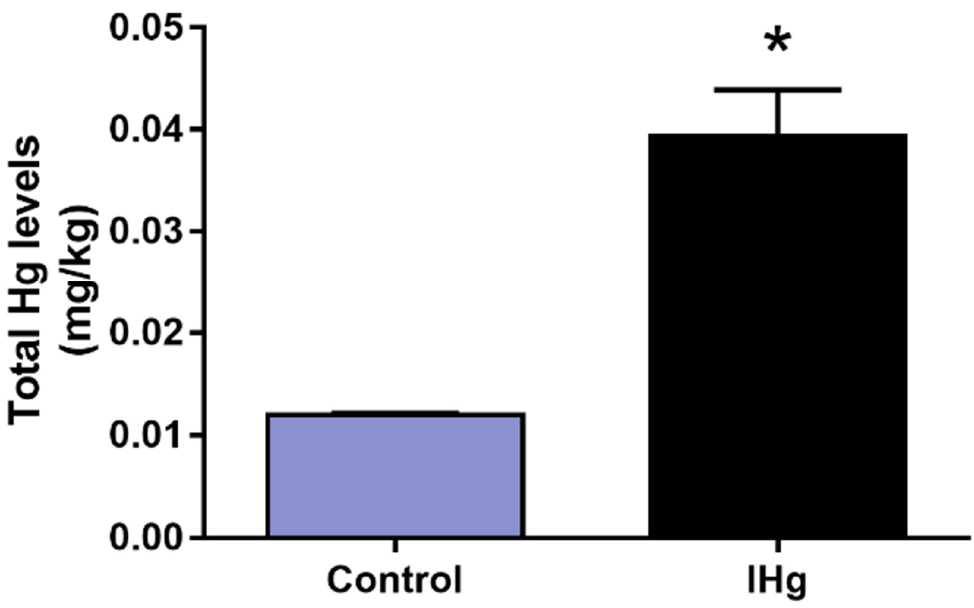
Figure 2. Total mercury (Hg) content in the cerebellum of adult rats exposed to 0.375 mg/kg of HgCl 2 for 45 days. Results are expressed as mg/kg (mean ± S.E.M.), * p < 0.05, t -Student test (n = 10). 2.3. IHg Long-Term Exposure Triggered Oxidative Stress in the Cerebellum of Adult Rats The IHg reduced the cerebellar ACAP in 66.15% ( ± 7%) in comparison with the control group (100 ± 6.67%; p = 0.0002) and in parallel, the LPO increased 41.70% ( ± 5.75) when compared with the control (100 ± 3.63%) ( p = 0.023) (Figure